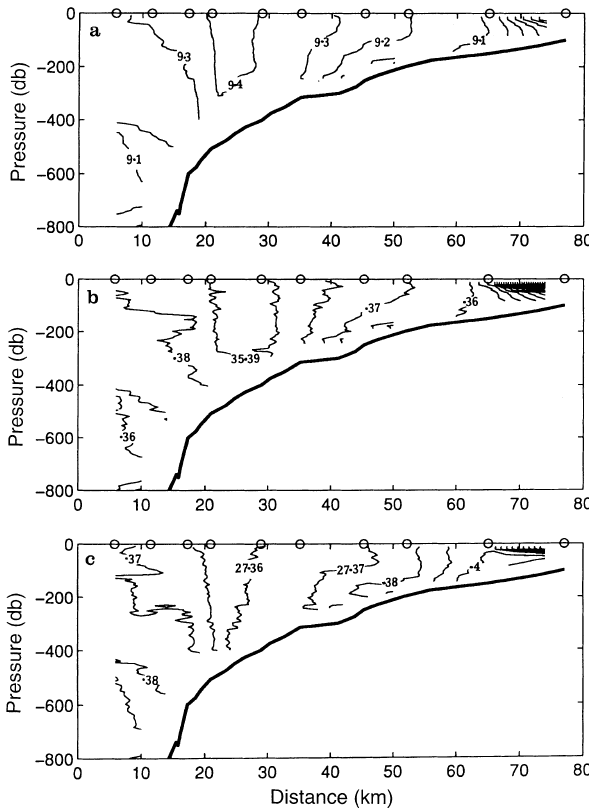
Fig. 3a–c. Vertical sections of a Potential temperature, b salinity and c (cid:114) (cid:104) , for the CTD transect shown in Fig. 1. Contour intervals are (a) 0 : 1 (cid:14) C, (b) 0.01 and (c) 0 : 01kgm (cid:255) 3 . Station positions are indicated by the open circles